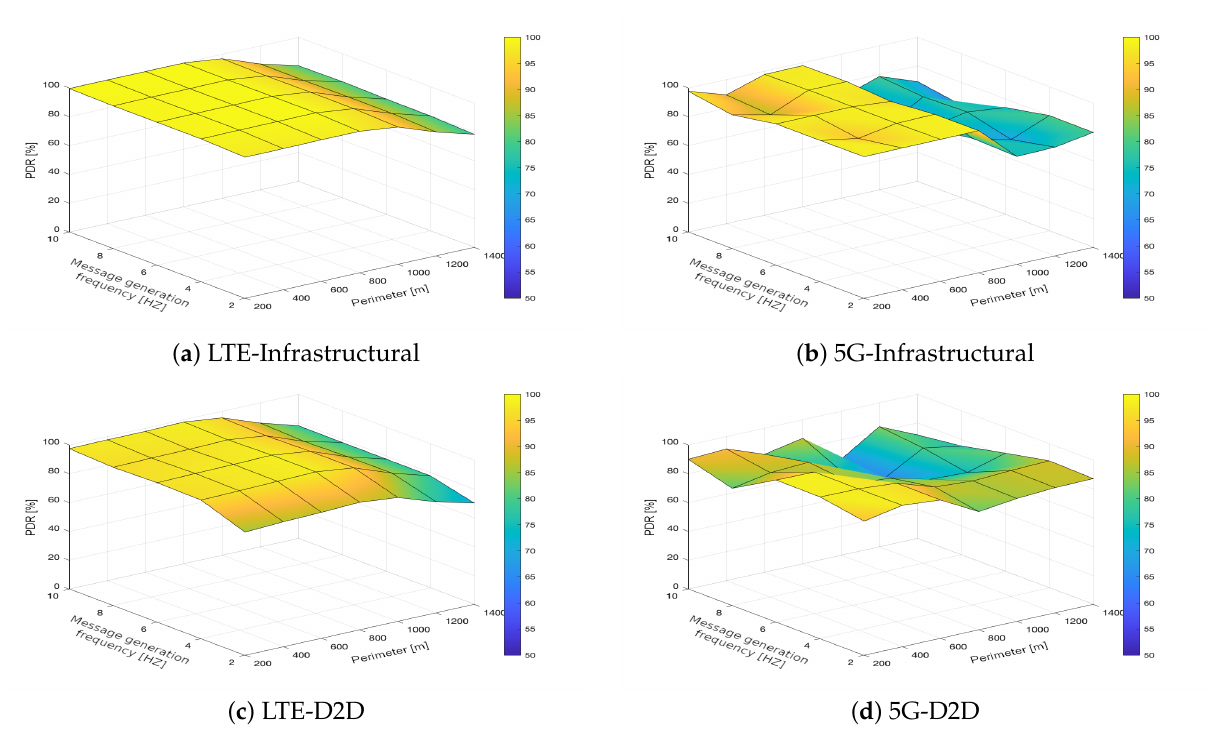
Figure 5. PDR simulated for all the investigated modes of the 4G-based and 5G-based C-V2X technologies and traffic intensity of 1000 vehicles per